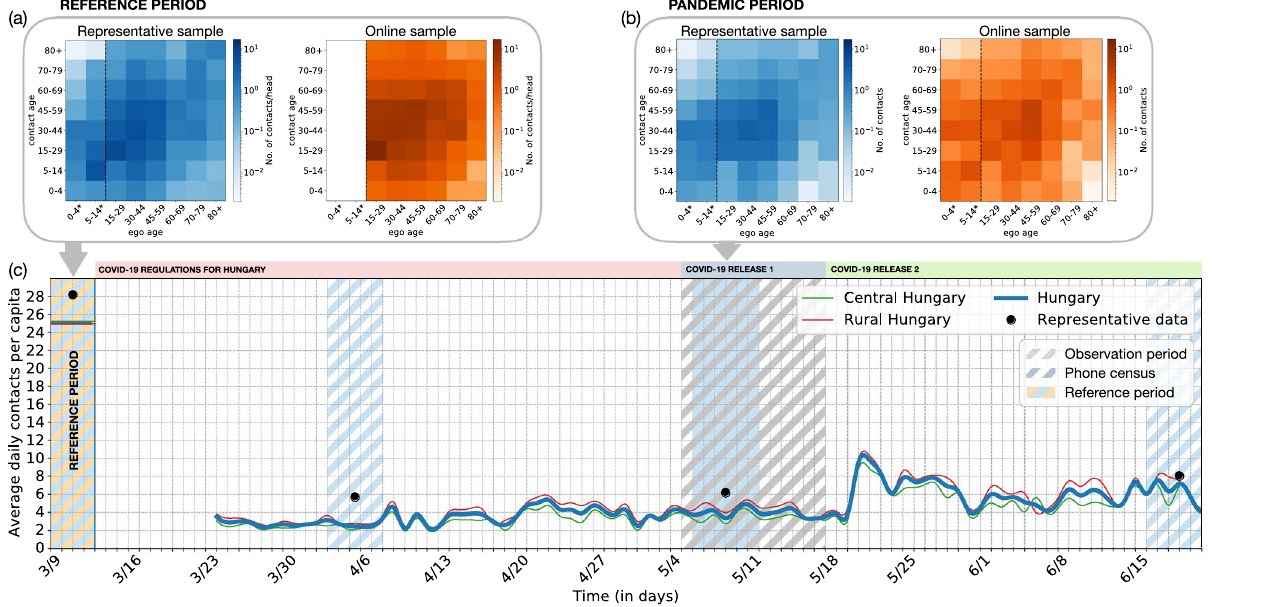
Figure 1. Contact dynamics, representative and non-representative age contact matrices. Age contact matrices measured during the ( a ) reference and ( b ) pandemic period via CATI survey methodology on a representative sample (blue) and via non-representative online data collection (orange) (for methodology see section on Construction of age contact matrices). Data for children under 18 (indicated with asterisk and vertical dashed lines) could not be collected directly due to privacy regulations, thus our data cannot provide a representative sample for the first two age groups. Their contact patterns are calculated based on the adult respondents’ responses on their children’s behavior. For the reference period at the online survey children’s contact patterns were not asked from their parents, therefore we do not have data on children’s contact patterns before the pandemic in the online sample. ( c ) Timeline of early pandemic regulations in Hungary and the average number of per capita daily proxy social contacts in rural areas (solid green line), the central area (red solid line) of Hungary, and in the whole country (blue solid line). While online data collection was continuously ongoing after the 23rd March 2020, representative data via telephone surveys were collected during the periods assigned by diagonal shading. Blue shades indicate telephone-based data collection (representative survey), while grey shades cover the online observation period of the actual study. Both methods retrospectively recorded the contact patterns about the reference period (before 13th March 2020), except for age groups under 15 in the online